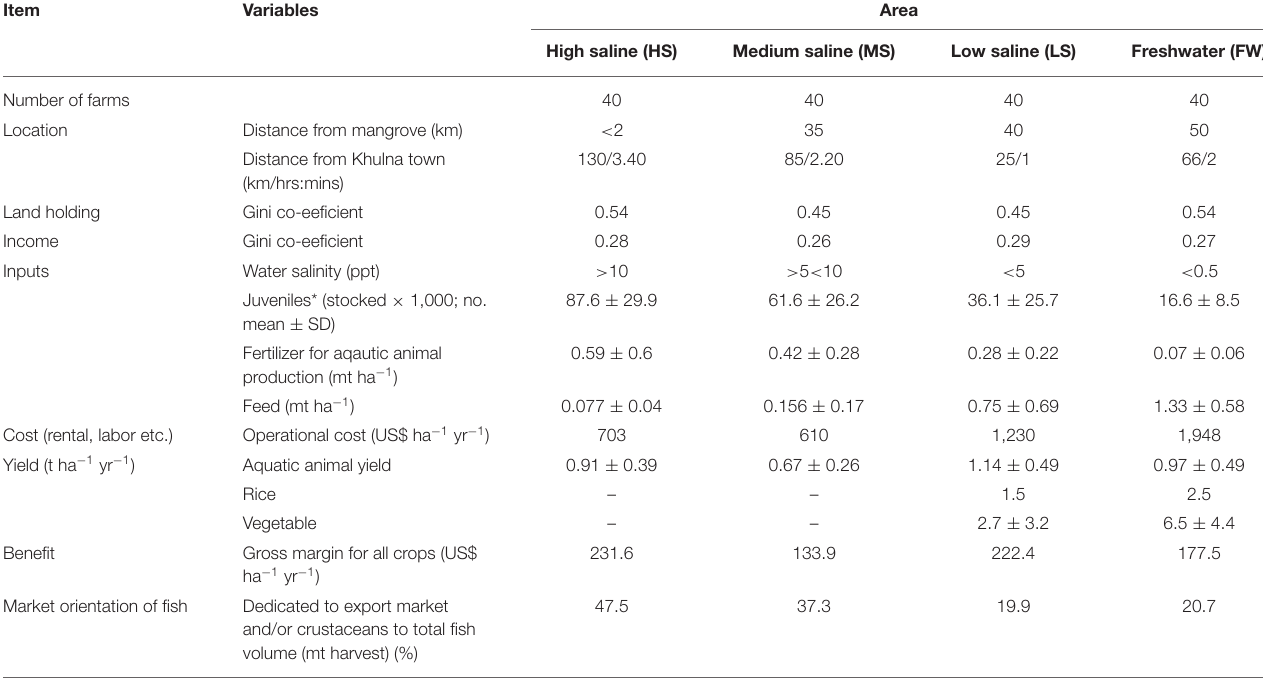
TABLE 1 | Key characteristics of aquaculture-agriculture system by